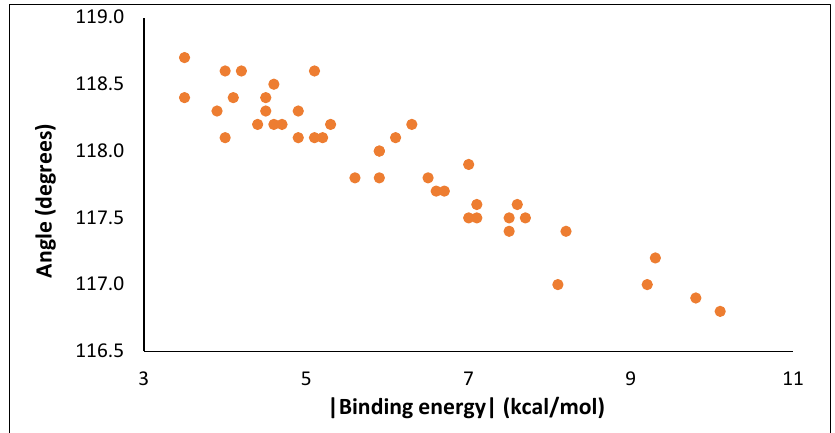
Figure 4. The angle (O Ŝ O) of SO 2 gas molecule as a function of the binding energy.